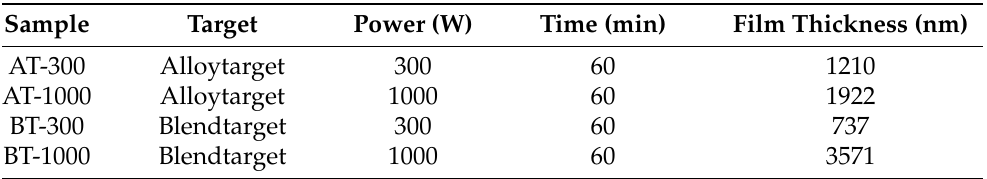
Table 1. Deposition parameters for the discussed samples (the time values refer to the actual deposition time excluding